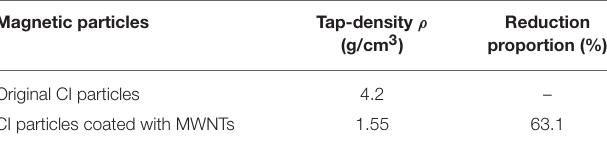
TABLE 1 | Comparison of the tap-density of the two types of magnetic particles.